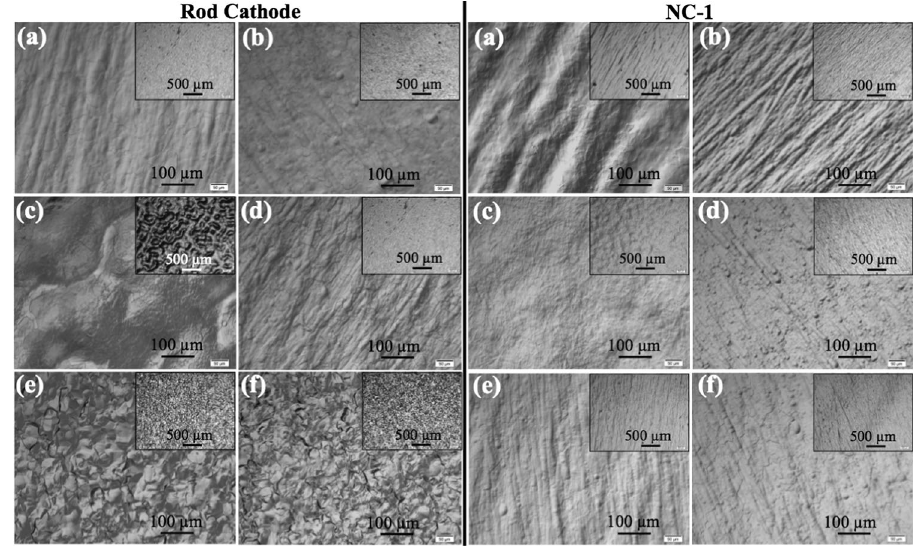
FIG. 9. Optical microscope images of the coupons after VEP with the rod cathode (left) and NC-1 (right). Coupons located at (a) top beam pipe, (b) bottom beam pipe, (c) top iris, (d) bottom iris, (e) and (f) equator. Insets show zoomed-out images of the